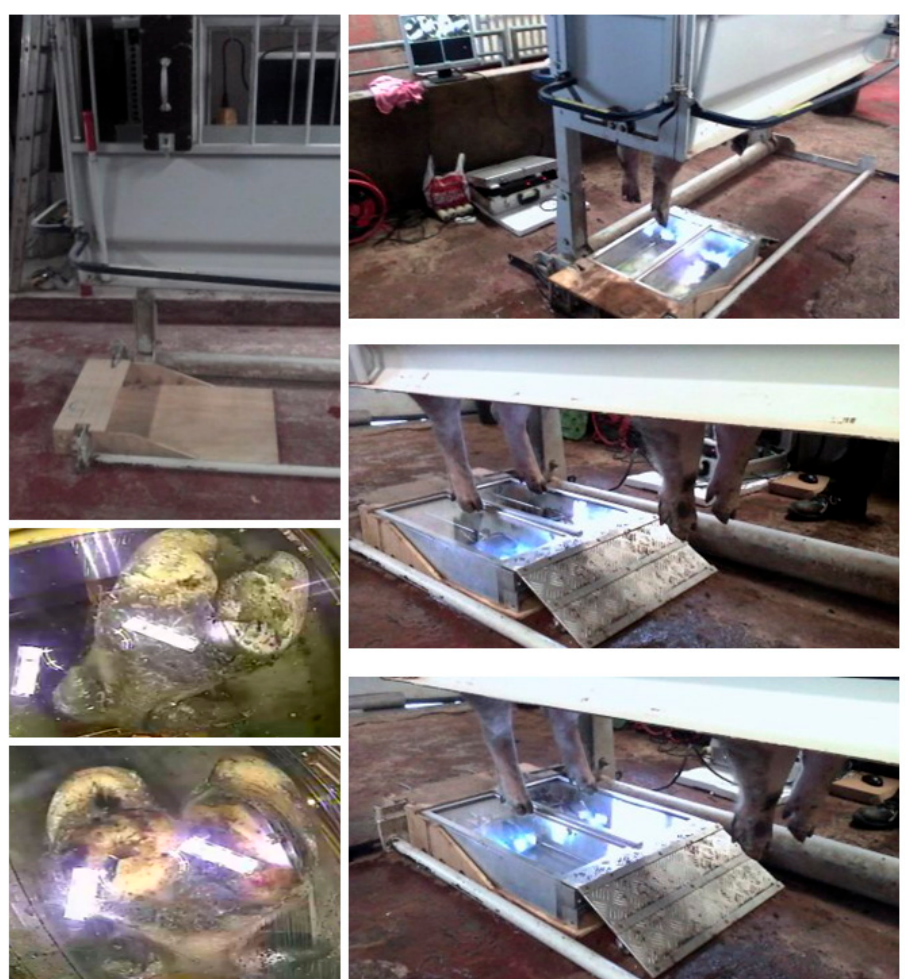
Figure 5. Experimental design for validating the Mobile Claw Scoring Device (MCSD). A wooden cover frame fitted over the core of the sow chute in which the MCSD was inserted to stabilise and protect against damage to the MCSD when sows entered the sow chute (with permission of © ZINPRO corporation, Eden Prairie, MN, USA, www.zinpro.com). When the sow stood on the MCSD, each camera was manually slid on its own rod to adjust to the position of the claws on the glass plates. Two snapshots were taken from the video recordings to visualise the view of the claws from the cameras.